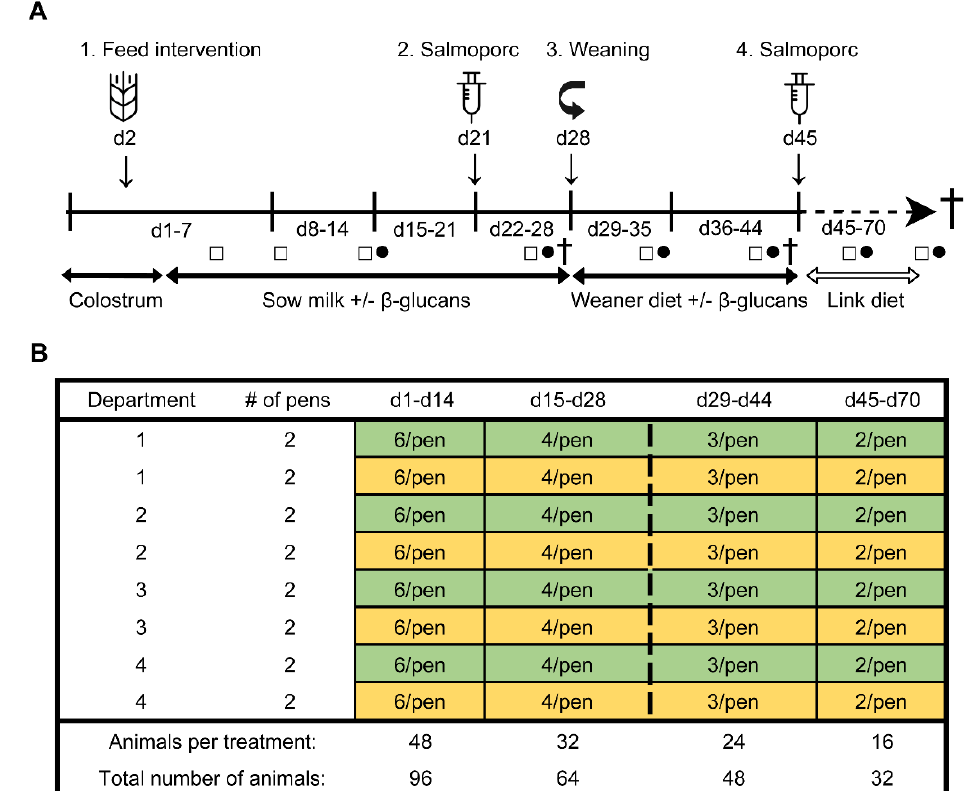
Figure 1. Study timeline ( A ). From day 2 until day 44, all piglets orally received either β-glucans or a control treatment (tap water) every other day (1). A sub-selection of piglets was weaned on day 28 (3). Pigs were vaccinated with Salmoporc ® on day 21 (primary vaccination; (2) and on day 45 (booster vaccination; (4). Faecal samples were collected on days 4, 8, 14, 26, 35, 43, 59 and 69 (squares; □). Blood samples were taken on days 14, 26, 35, 43, 59, and 69 (circles; ●). A subset of animals were sacrificed on days 27, 44, and 70 (cross; †). Schematic representation of the experimental design showing the remaining number of animals per treatment over time as determined by deselection or dissection of animals ( B ). The control and the β-glucan groups are presented as yellow and green, respectively. The dashed line separates the pre-weaning and post-weaning time points.